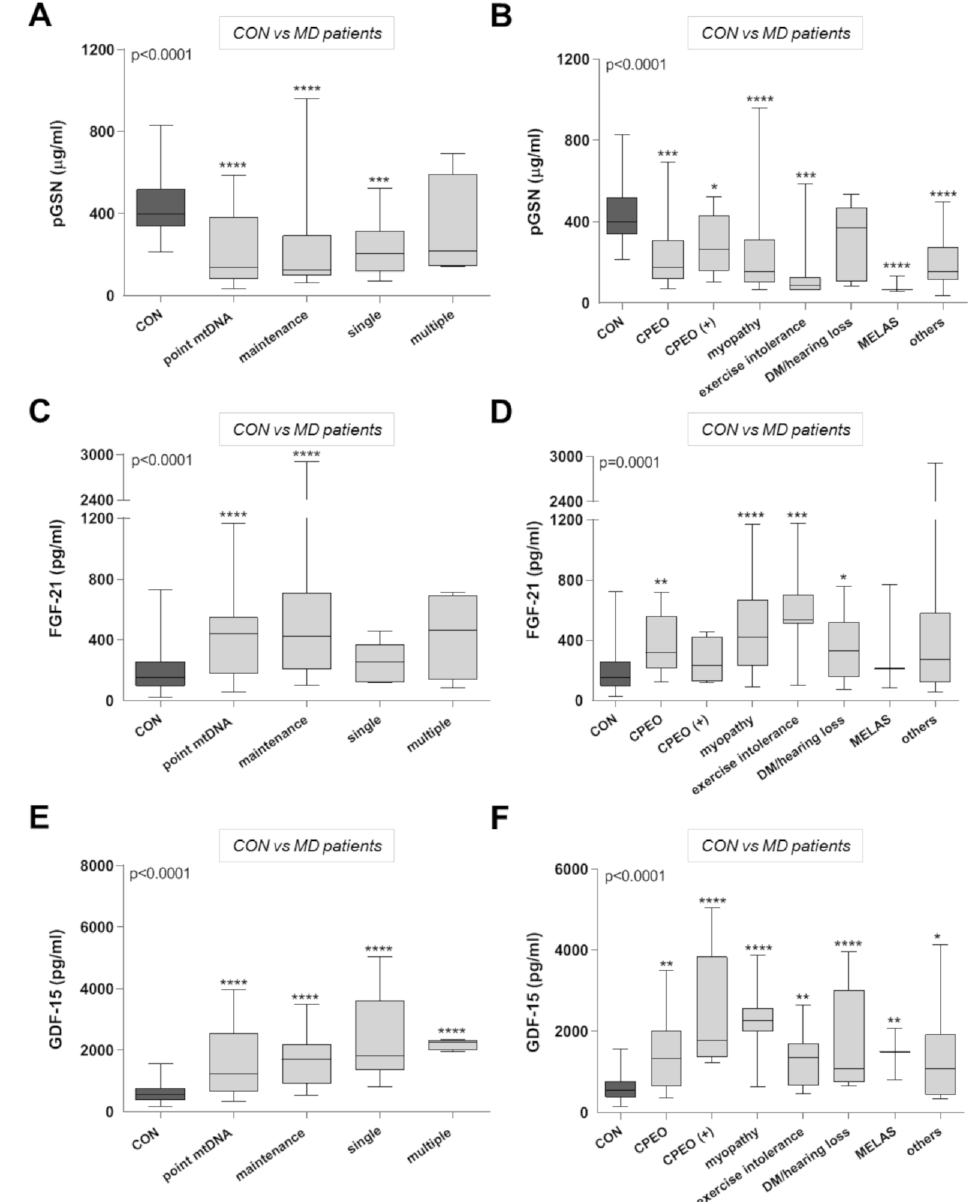
Figure 4. Average plasma concentrations of pGSN, FGF-21, and GDF-15 in MD patients categorized according to their genetic and clinical features. Average concentrations of pGSN ( A ), FGF-21 ( C ), and GDF-15 ( E ) in MD patients, categorized according to their genetic diagnosis. Point mtDNA = patients with mtDNA point mutations ( n = 25), mtDNA maintenance = mutations in nuclear genes affecting mtDNA expression or maintenance ( n = 23), single mtDNA deletion ( n = 8), and multiple mtDNA deletions ( n = 4). ( B ) pGSN, ( D ) FGF-21, and ( F ) GDF-15 concentration in MD patients categorized according to their clinical phenotypes. CPEO = Chronic Progressive External Ophthalmoplegia ( n = 9); CPEO plus ( n = 5); Myopathy ( n = 17); Exercise Intolerance ( n = 7); MELAS = Mitochondrial encephalopathy, lactic acidosis, and stroke-like episodes ( n = 3); diabetes mellitus (DM) with hearing loss ( n = 9); others = other phenotypes ( n = 10). For ( A – F ): Data are presented as the median, interquartile range, minimum, and maximum. Kruskal–Wallis test p -values for the different groups are indicated in the figures. Post hoc Mann–Whitney U test p -values: **** p < 0.00001, *** p < 0.0001, ** p < 0.001, * p <